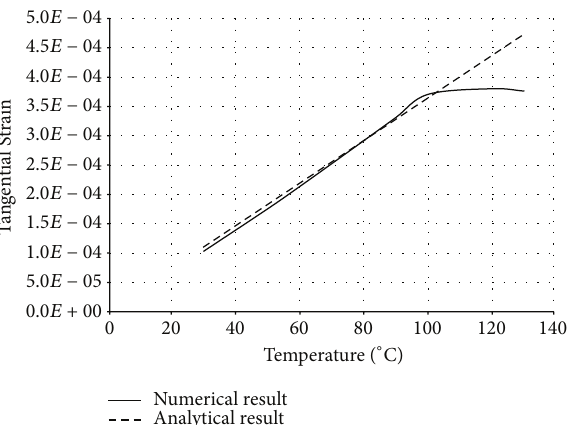
Figure 19: Comparison of radial strain in concrete.